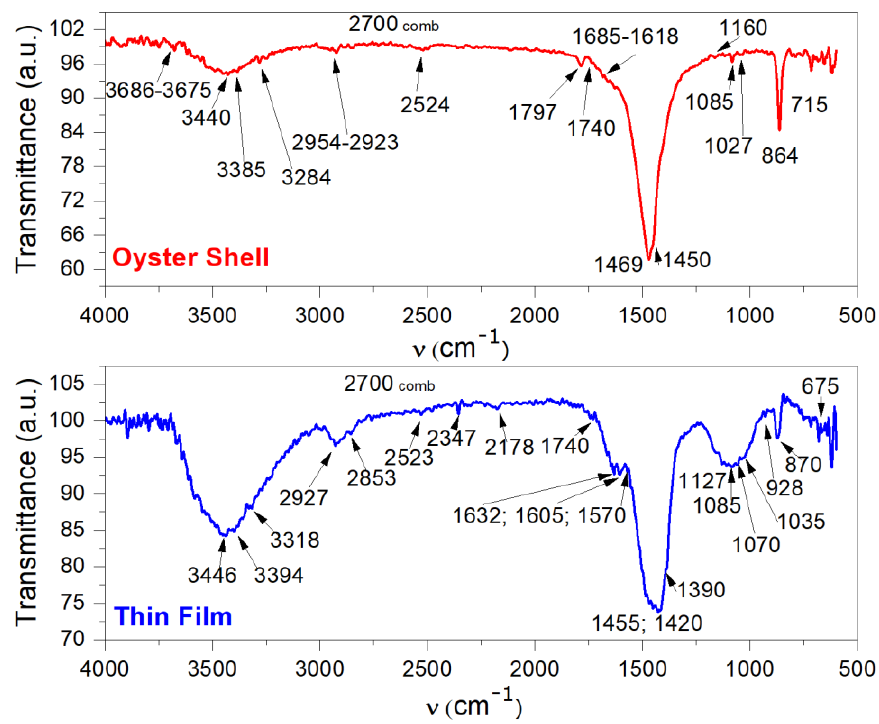
Figure 3. FTIR spectra of Oyster Shell natural biocomposite and thin film obtained with LICD method.